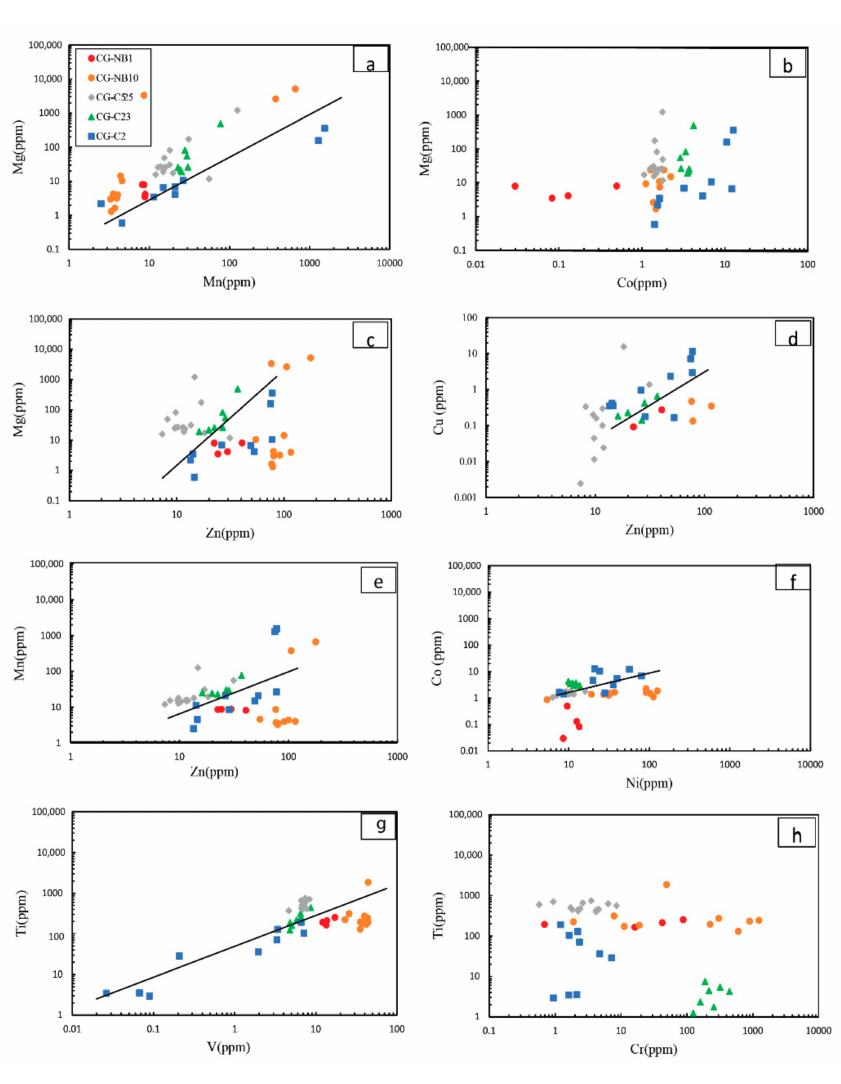
Figure 11. Binary diagrams of magnetite chemical compositions from the Nabeba BIF: ( a ) Mn vs. Mg,